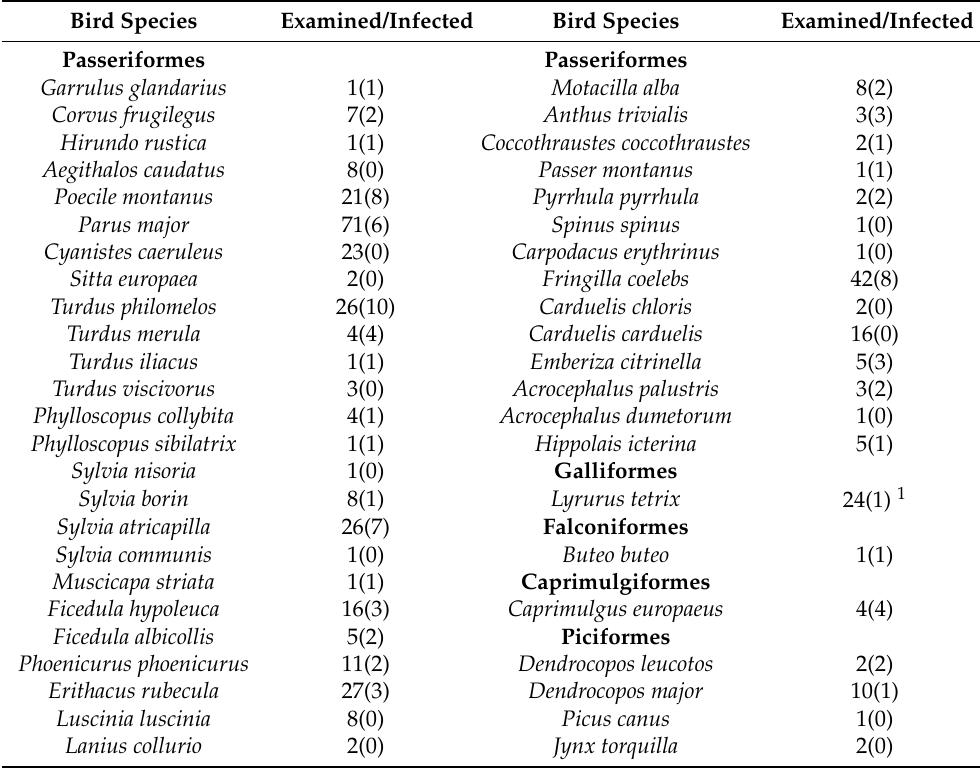
Table 1. List of land birds examined in